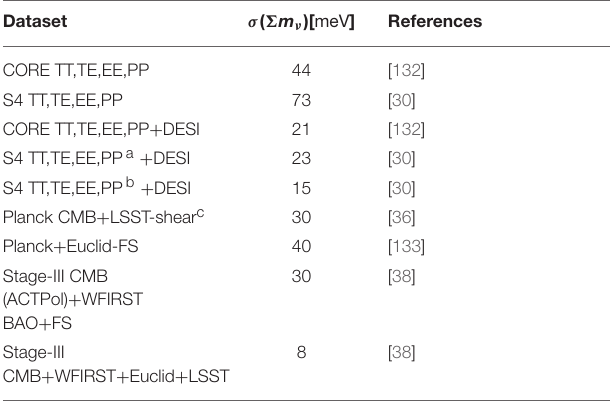
TABLE 2 | Expected sensitivity on 6 m ν from different combination of future cosmological data.